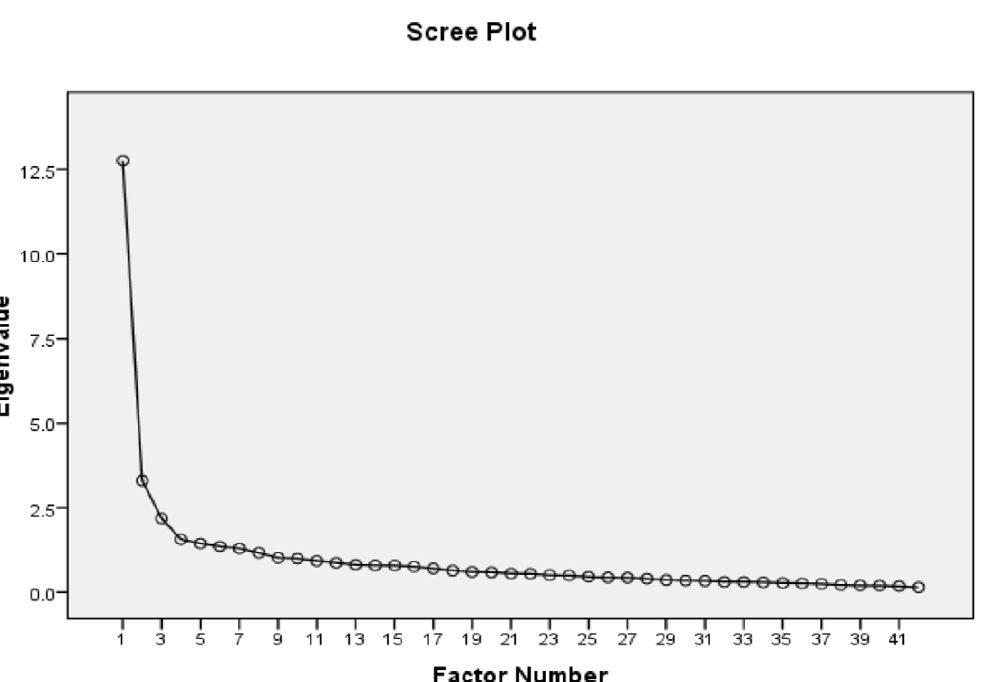
Figure 1. Scree plot for principal axis factor analysis. Figure 1 shows the scree plot for the principal axis factor analysis of the STS-3. Eigenvalues of the extracted factors are shown on the y-axis, while the ordinal factor number is shown on the